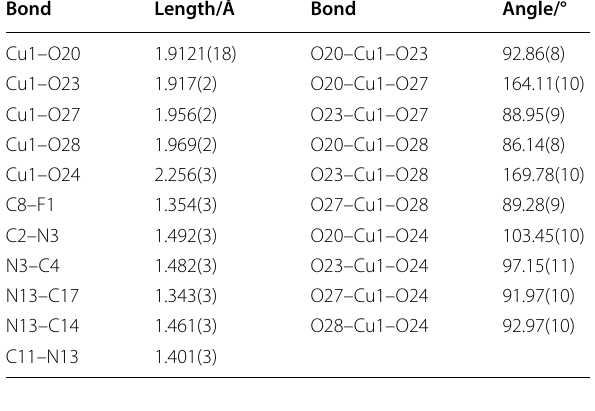
Table 2 Selected bond lengths (Å) and bond angles (°) in the crystal structure of